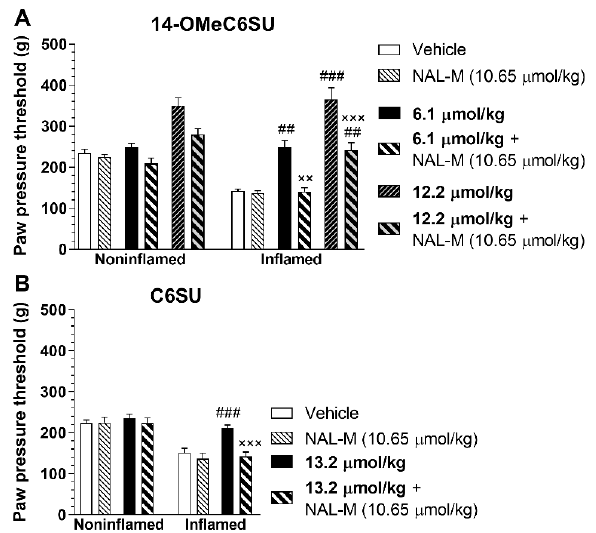
Figure 7. Antagonist action of co-administered naloxone methiodide (NAL-M) on the antinociceptive effect of 14-OMeC6SU ( A ) and C6SU ( B ) in CFA-induced inflammatory pain 30 min after the injection of the compounds. Figures indicate the paw pressure threshold in g-s in the presence of 14-OMeC6SU, C6SU and NAL-M, and in the presence of NAL-M co-administered with 14-OMeC6SU or C6SU in the indicated dosages. Data represent means ± S.E.M. (n = 5–11 per group). # significant difference within the inflamed paw compared to vehicle, NAL-M and to 6.1 µmol/kg 14-OMeC6SU + NAL-M in panel A (two-way ANOVA, Tukey’s multiple comparisons test). × significant difference within the inflamed paw compared to the correspondent test compound alone in the appropriate dose (two-way ANOVA, Tukey’s multiple comparisons test). ××/## P < 0.01; ×××/### P < 0.001.